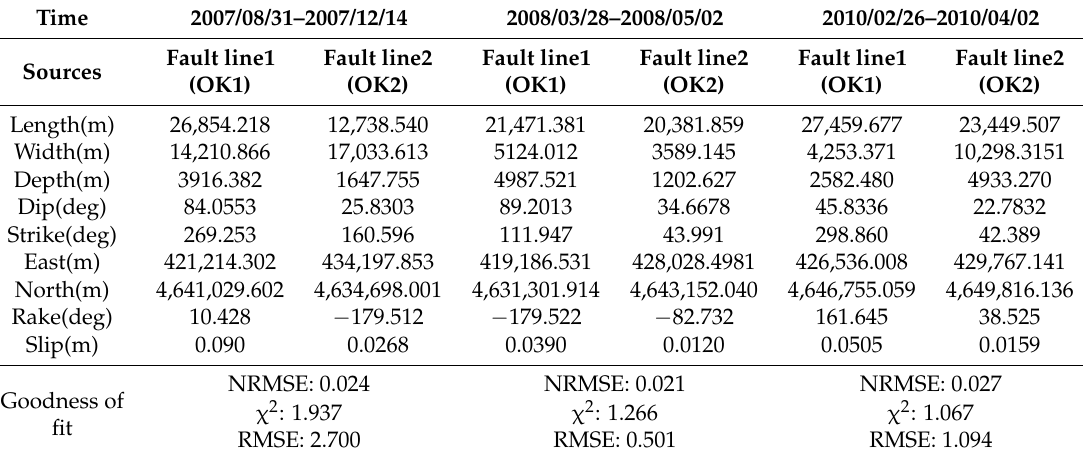
Table 4. Source parameters determined by inversion. See Figure 12 for location of deformation sources (OK1 to